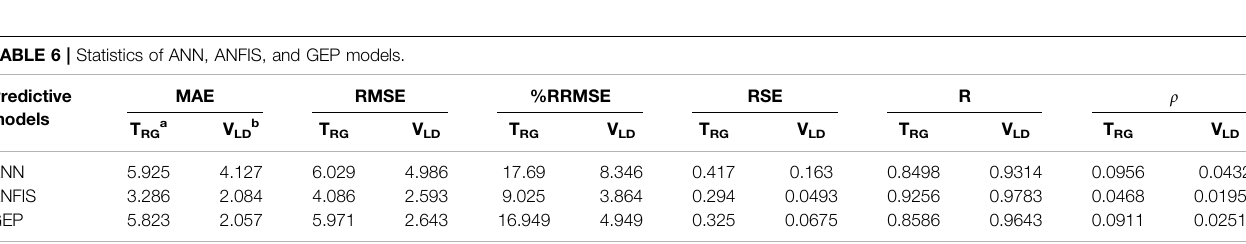
TABLE 6 | Statistics of ANN, ANFIS, and GEP models. Predictive